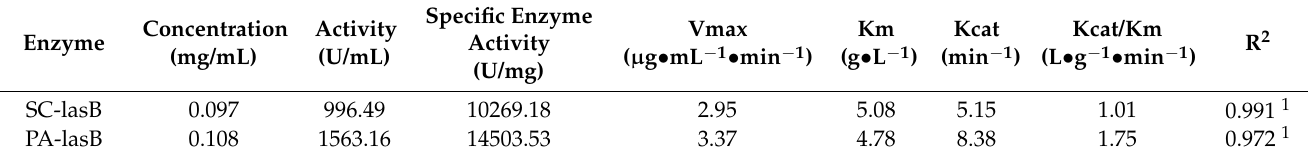
Table 3. Enzyme kinetic parameters of SC-lasB and